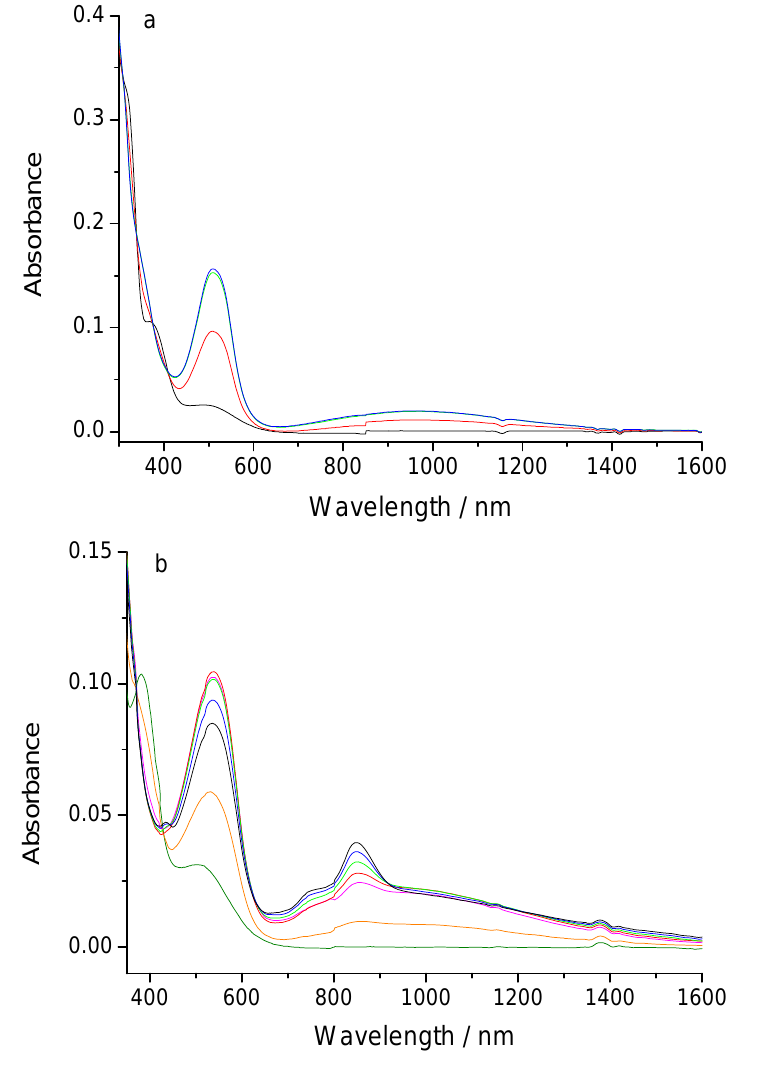
Figure 1. UV-vis-near-IR spectral change of 9.31 × 10 -5 M AqFcSAc (0 (black), 0.5 (red), 1.0 (green), 2.0 (blue) equiv of TfOH) (a) and 1.15 × 10 -4 M FcAqFcSAc (0 (olive), 0.5 (orange), 1.0 (magenta), 2.0 (red), 3.0 (green), 5.0 (blue), 8.0 (black) equiv of TfOH) (b) upon the addition of TfOH in